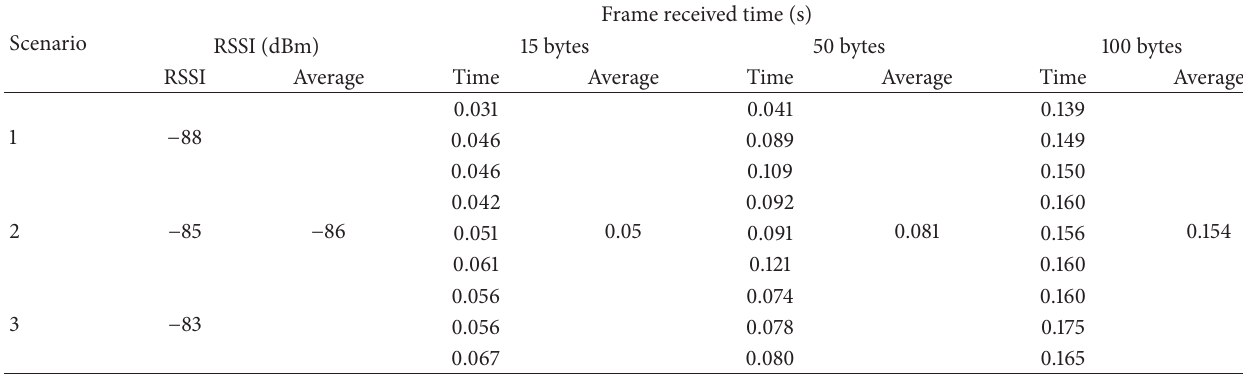
Table 8: Experimental results of Case 4 .